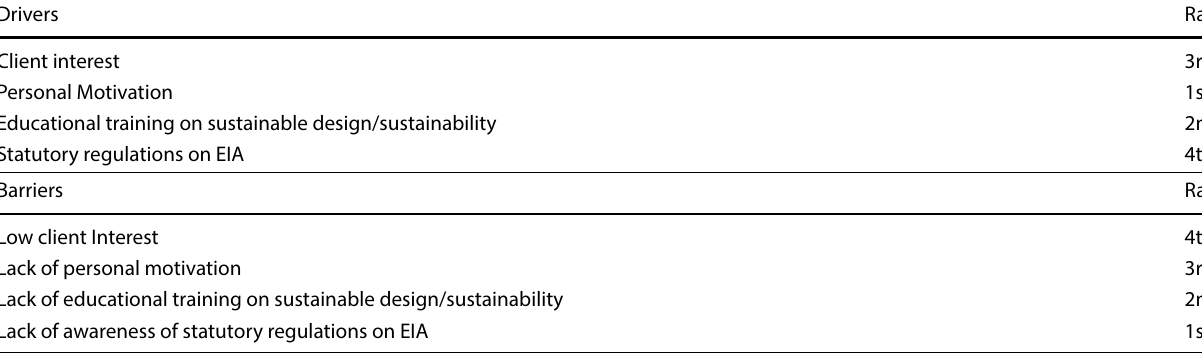
Table 4 Designers’ perspectives of drivers and barriers to consideration of sustainable design principles ranked by level of influence